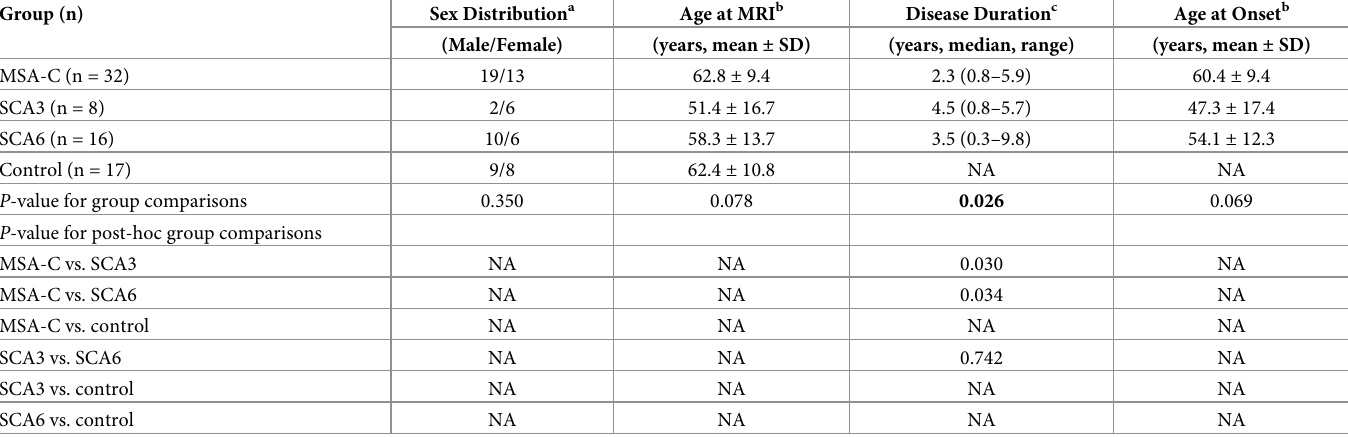
Table 1. Demographic and clinical data of the patients with cerebellar subtype multiple system atrophy (MSA-C), spinocerebellar ataxia type 3 (SCA3), and type 6 (SCA6) and controls. Group (n) Sex Distribution